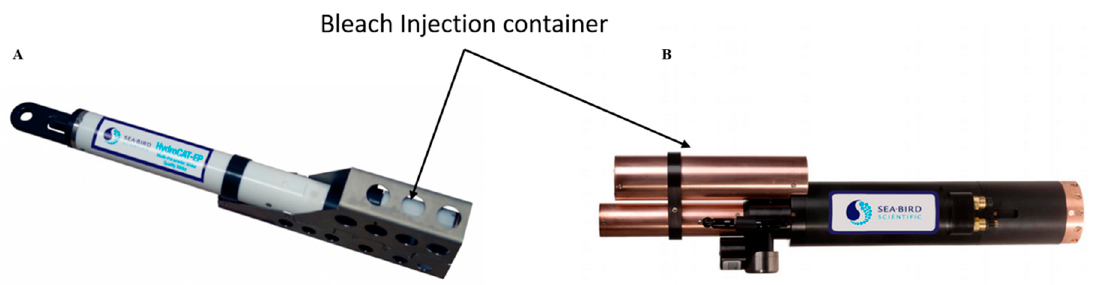
Figure 4. Bleach Injection container. ( A ) HydroCAT-EP, Sea-Bird Scientific [45]; ( B ) Water Quality Monitor (WQM) Wet-Labs and Sea-Bird Scientific sensor [50] (reproduced with permission of Sea-Bird Scientific, Bellevue, WA,